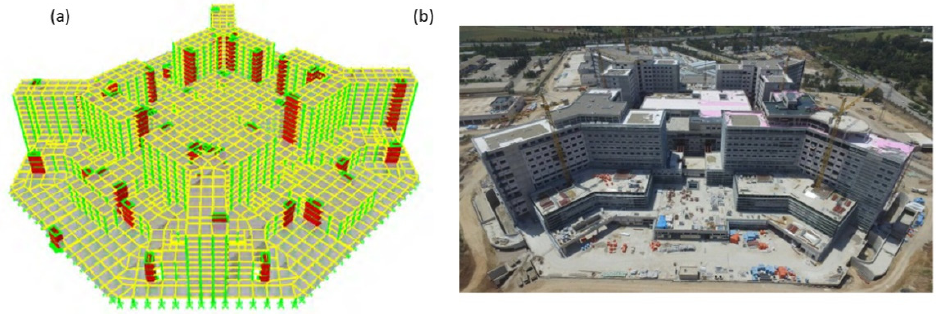
Figure 33. ( a ) Finite element model of Adana City Hospital. ( b ) Construction of Adana City Hospital (Courtesy of Rönesans Construction Inc., Adana,Turkey).